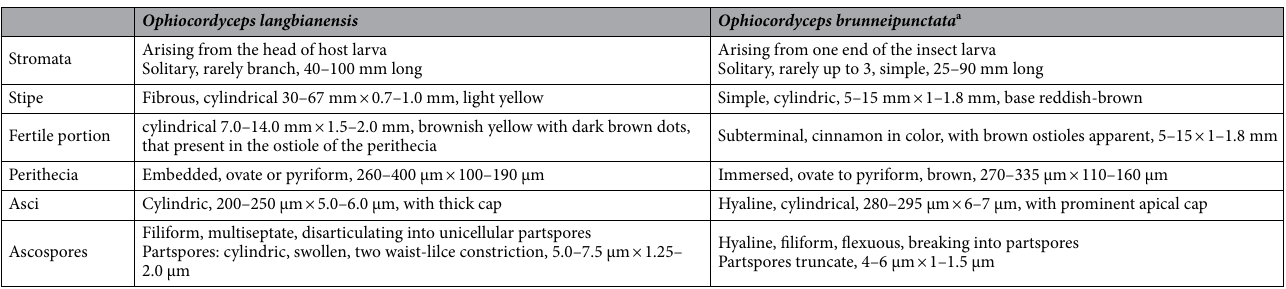
Ophiocordyceps langbianensis Ophiocordyceps brunneipunctata